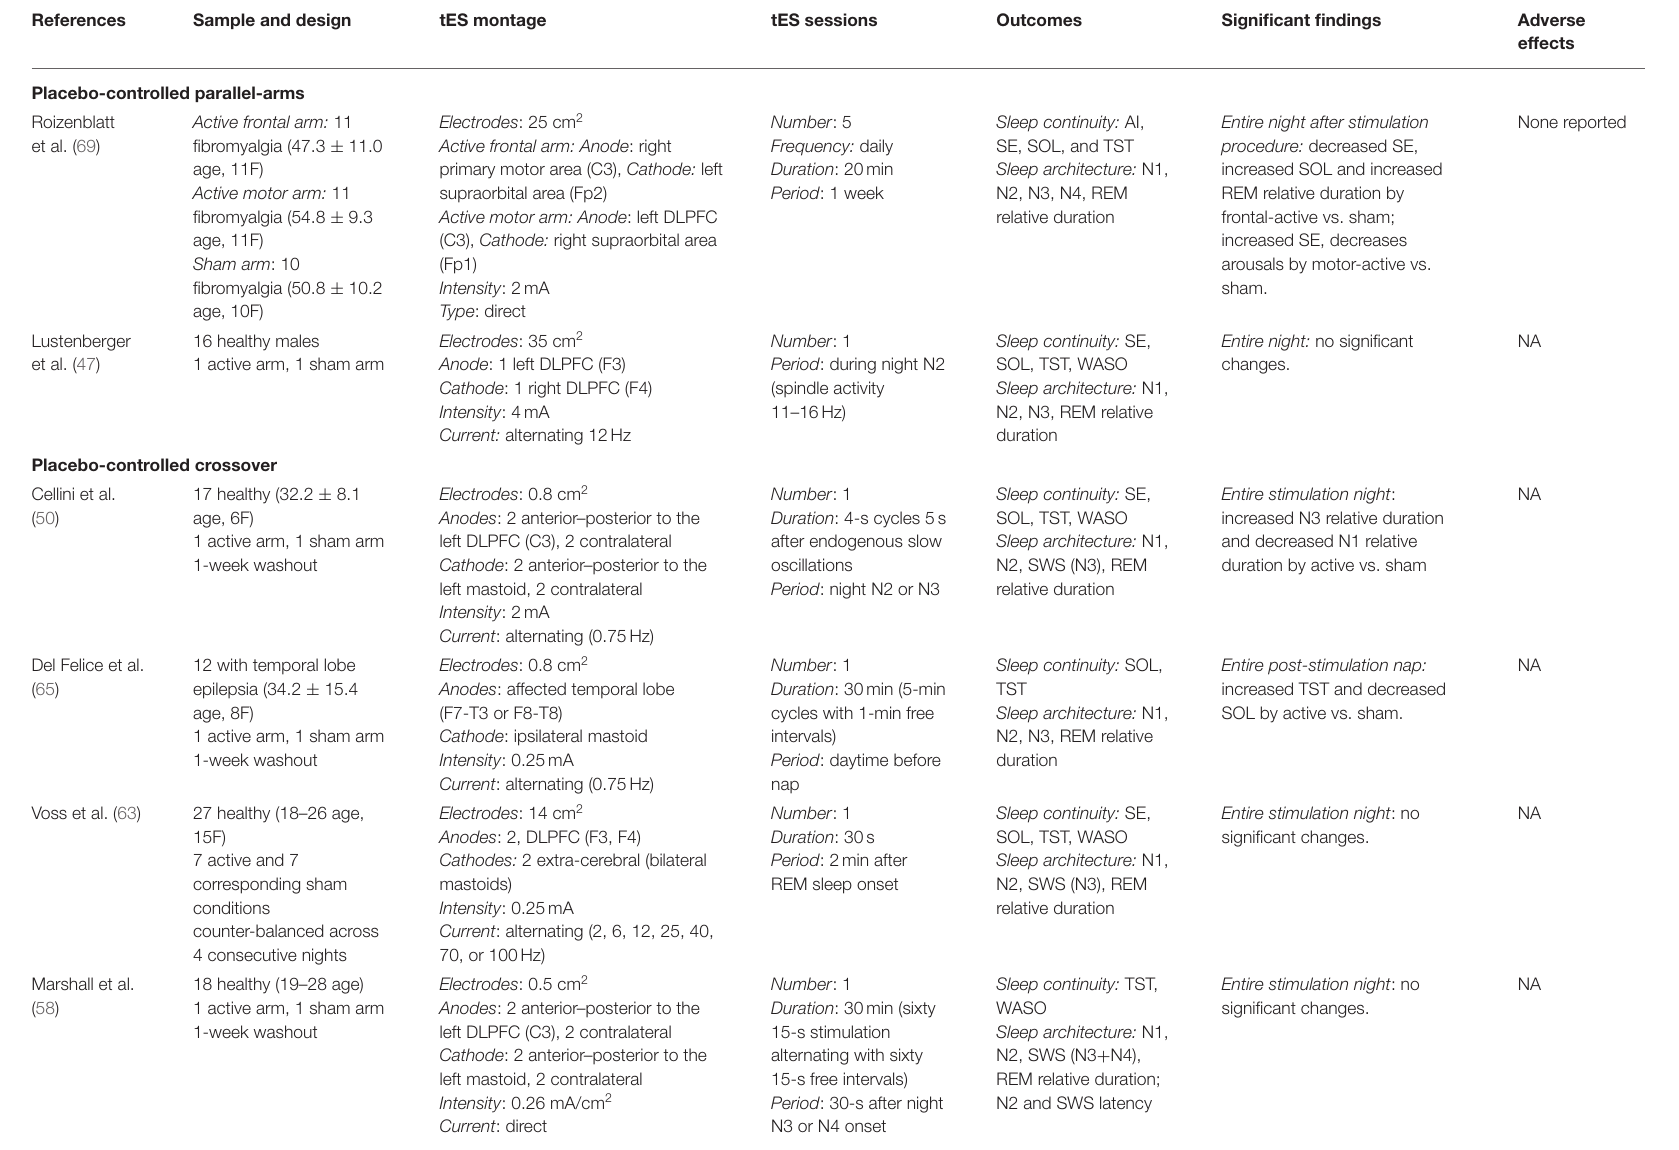
TABLE 2 | Impact of transcranial electrical stimulation on pattern aspects of